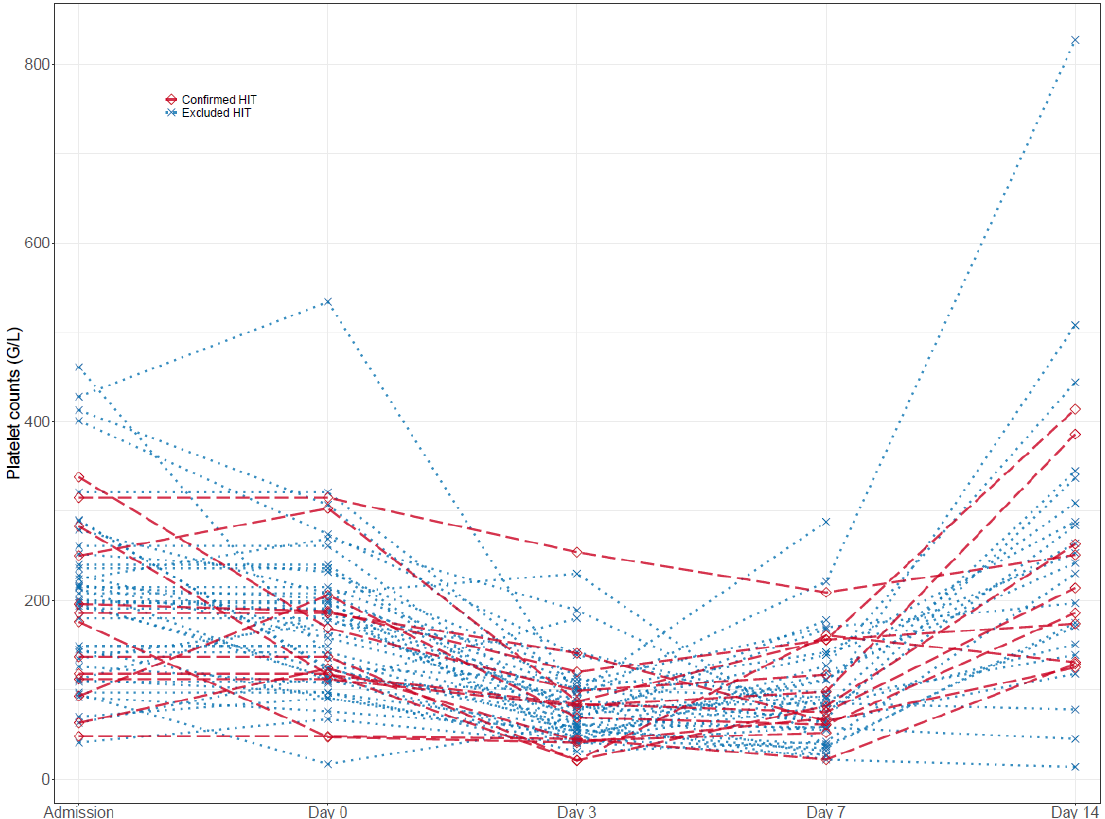
Figure 2. Time course of platelet counts in excluded and confirmed HIT patients. Outcome. The median length of ICU stays [d] (10.5 vs. 20.6, p = 0.018) and duration of mechanical ventilation [h] (189 vs. 398, p = 0.015) was significantly lower in excluded HIT compared to confirmed HIT. However, in-hospital mortality (43% vs. 38%, p > 0.999) and mortality after one month (35% vs. 38%, p > 0.999), three months (43% vs. 46%, p > 0.999), and twelve months (53% vs. 46%, p = 0.938), as well as a neurological